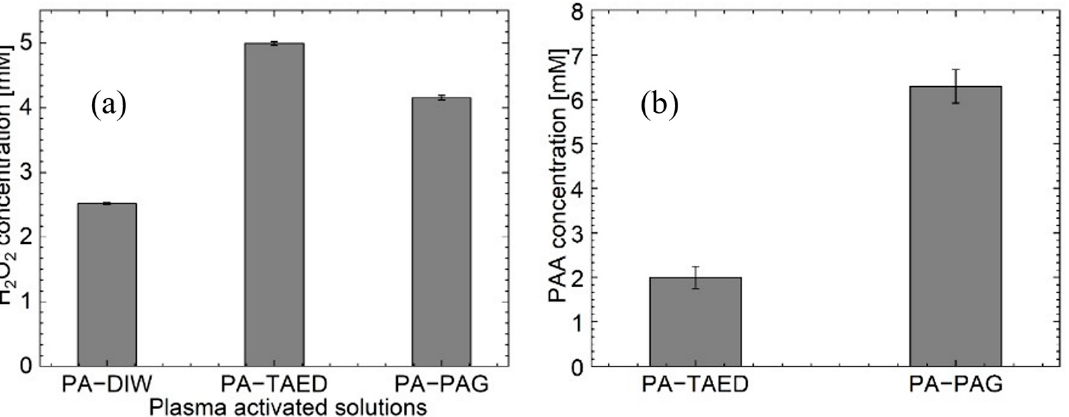
Figure 7. Concentrations of ( a ) H 2 O 2 and ( b ) PAA produced in PA-DIW, PA-TAED and PA-PAG. Corresponding calibration curves used to calculate the concentrations are shown in Figures 2 and 3.